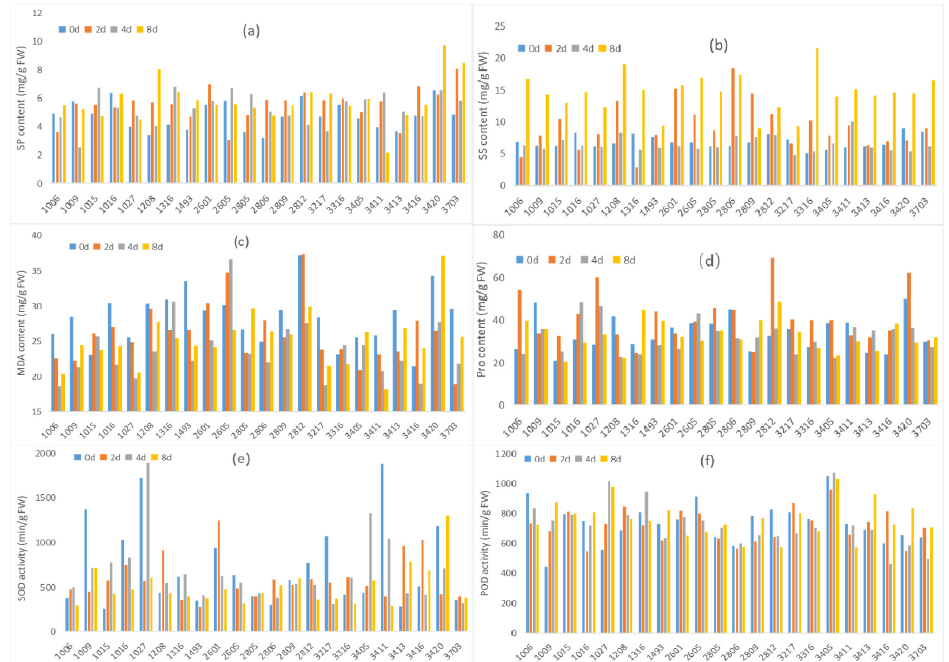
Figure 1. Physiological and biochemical response of 22 genotypes of Saccharum spontaneum to low- temperature stress. ( a ) SP, ( b ) SS, ( c ) MDA, ( d ) Pro, ( e ) SOD, and ( f ) POD. Note: According to the measurement results, the value of each parameter showed no significant variation in each control sample at different sampling points; therefore, only the value at 0 days is shown in the figure for clarity.